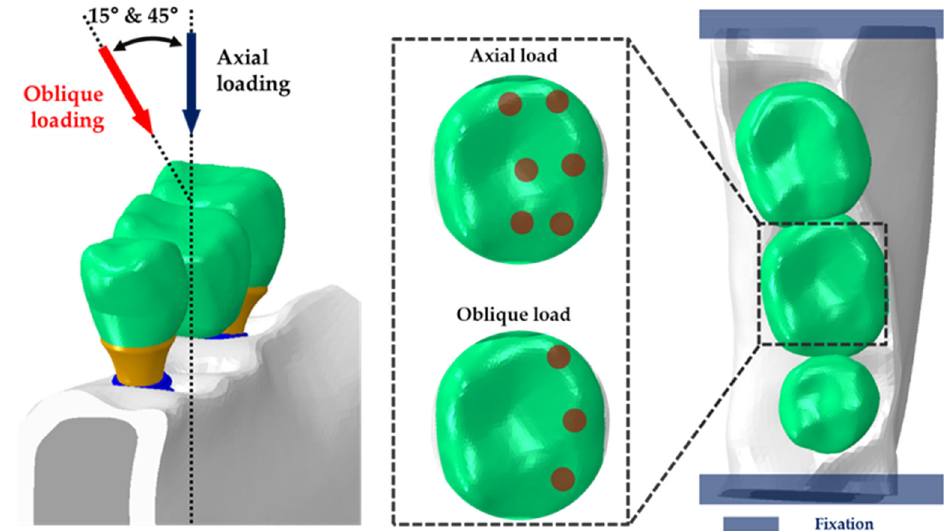
Figure 5. Loads and boundary conditions of the finite element model. A load of 100 N was applied